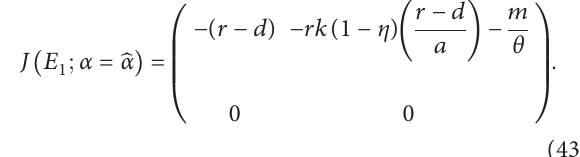
Table 2: Different conditions for existence of interior steady states. Here, 􏽥 α � 1 − ( 2 m / c ( θ − mh )) and 􏽢 α � 1 − ( m / c ( θ − mh ))(( r − d ) / a + a / ( r − d )) . Cond. 1 Cond. 2 Cond. 3 No. of coexistence